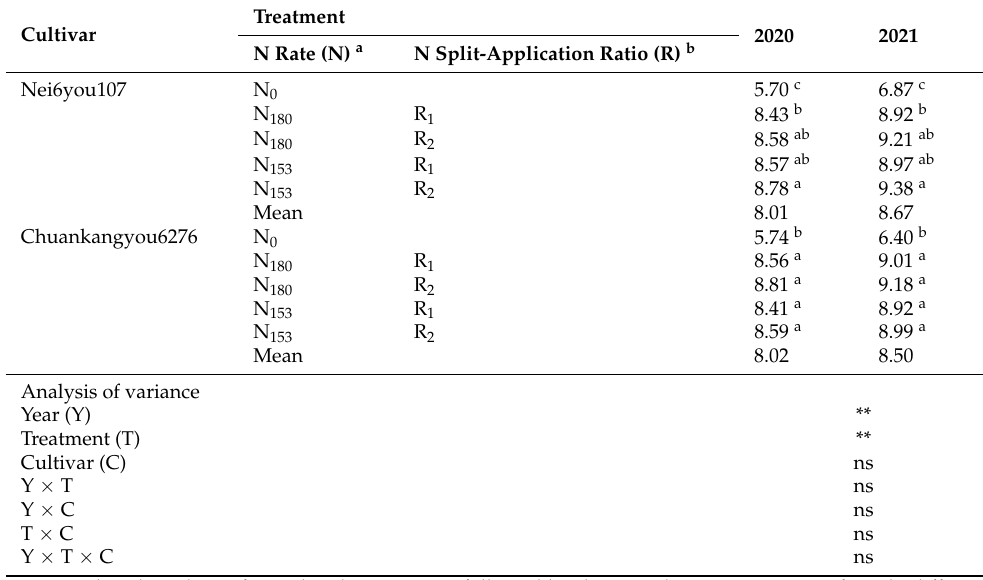
Table 2. Effects of different N management practices on grain yield (t ha − 1 ) in hybrid rice grown in the no-tillage, direct-seeded (NTDS) cropping system. Treatment Cultivar